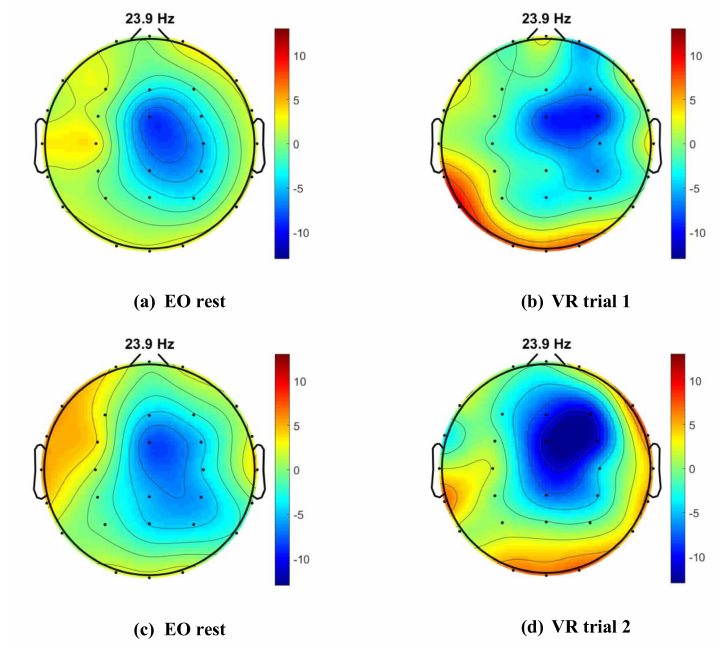
Figure 13. Topomap in high-beta sub-bands during ( a ) eyes-open resting ( b ) VR-trial 1, ( c ) eyes-open resting, and ( d ) VR trial 2. Increase in high-beta activity observed in the posterior areas during VR trials compared to eyes-open